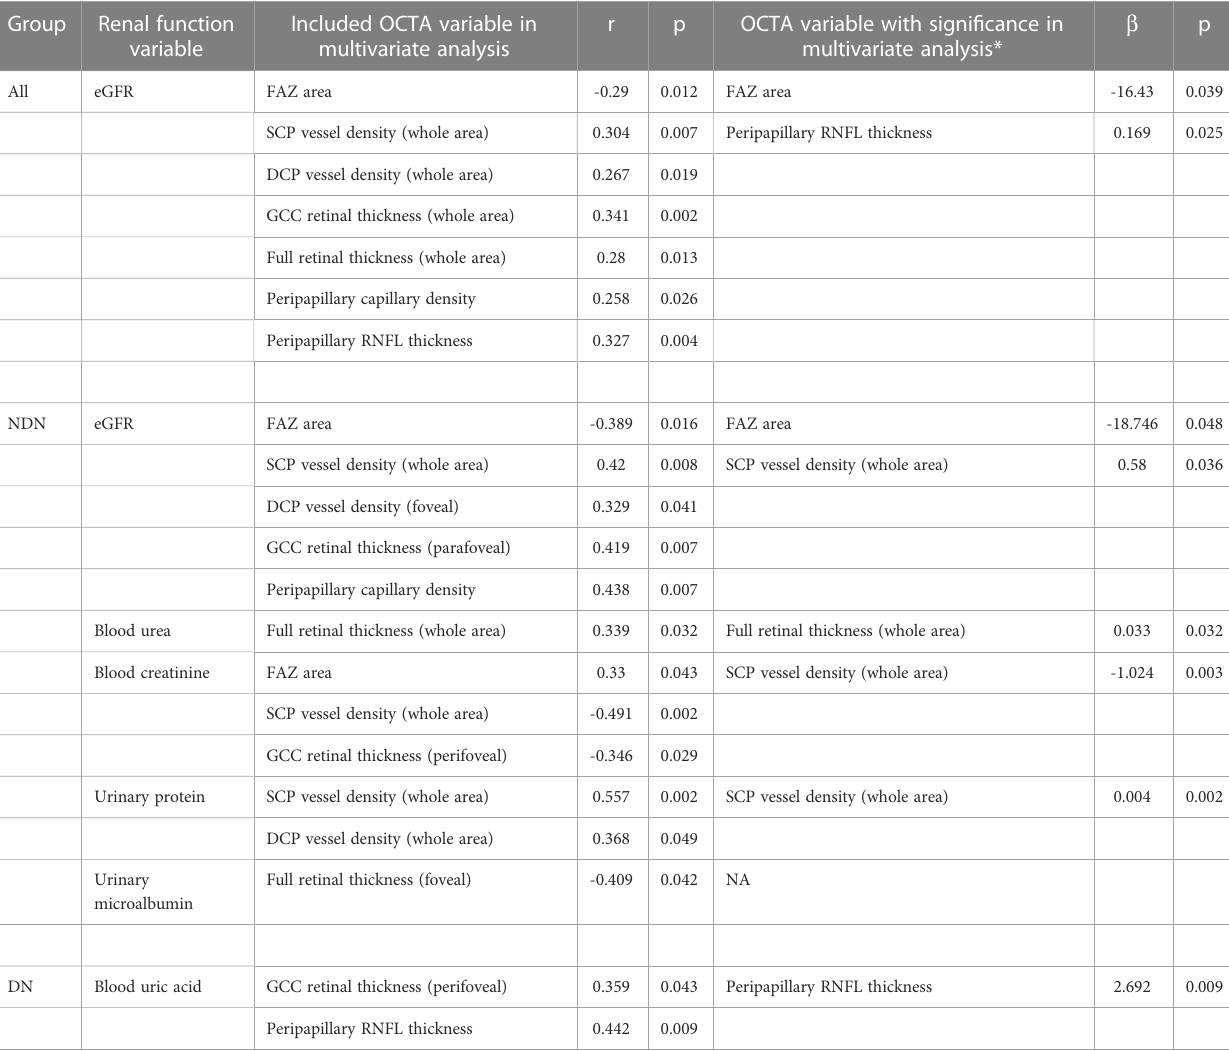
TABLE 7 Included Optical coherence tomography angiography (OCTA) variables and variables with signi fi cance in multivariate linear regression analyses for different renal function variables. Group Renal function Included OCTA variable in r p OCTA variable with signi fi cance in variable multivariate analysis multivariate